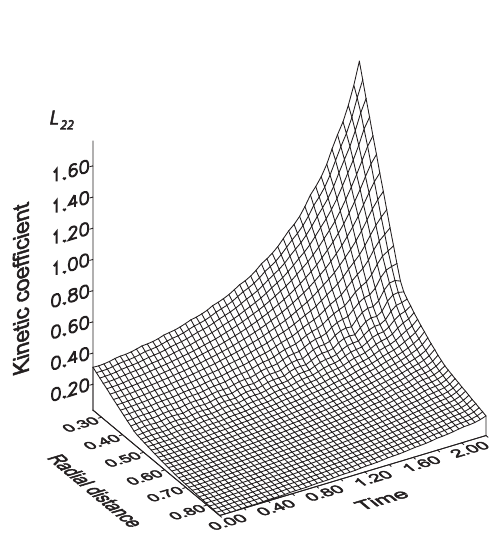
Figure 4.11 . Variation of the kinetic coe ffi cient L tance and time.